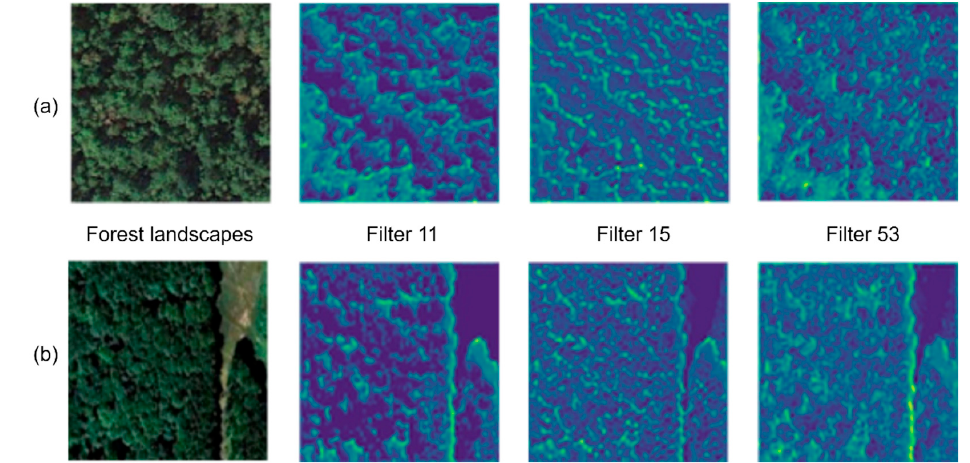
Figure 13. Forest landscapes from AID dataset. Row ( a ) denotes a sample image and its feature maps. Row ( b ) is sample of forest landscape from the different location. Notice that Filters 11, 15, and 53 depict features with varying grain sizes, yet they originate from an identical forest landscape.